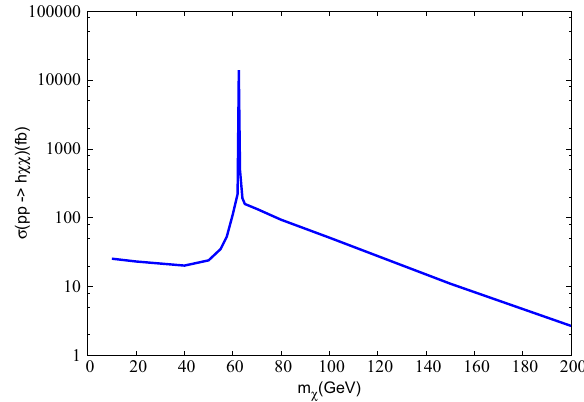
Fig. 7 Production cross-section of pp → h χχ at 13 TeV as a func- tion of dark matter mass, λ (cid:4)χ ≈ 4 π (perturbative upper limit) and (cid:7) ≈ 5 TeV (the corresponding approximate lower limit derived from Fig. 6). The cross-sections are calculated at parton level using Mad- graph@MCNLO